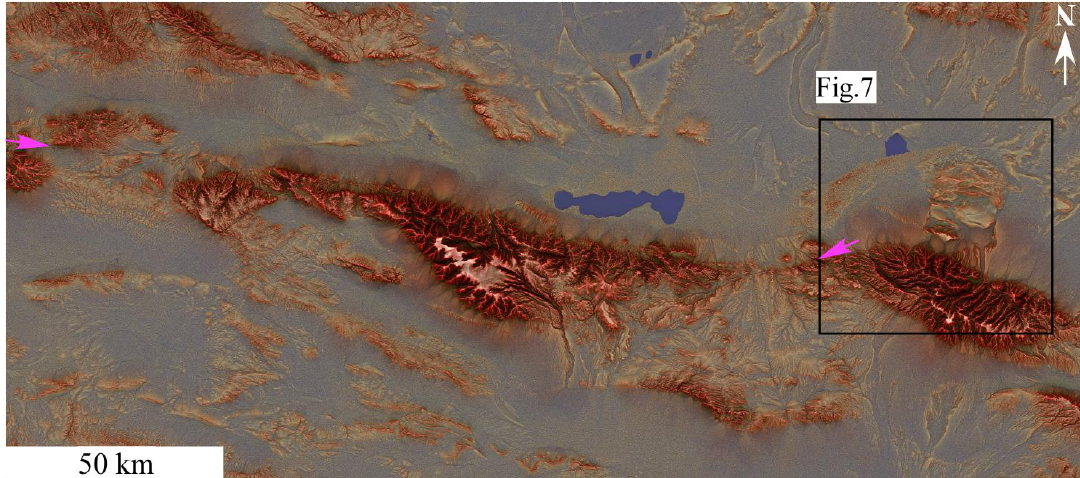
Figure 4. Topographical features along the surface ruptures caused by Gobi-Altay earthquake. Pink arrows indicate fault